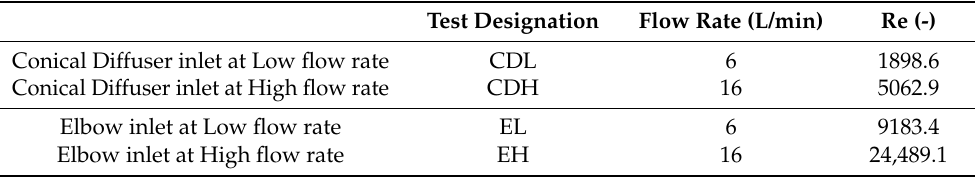
Table 1. Experimental tests carried